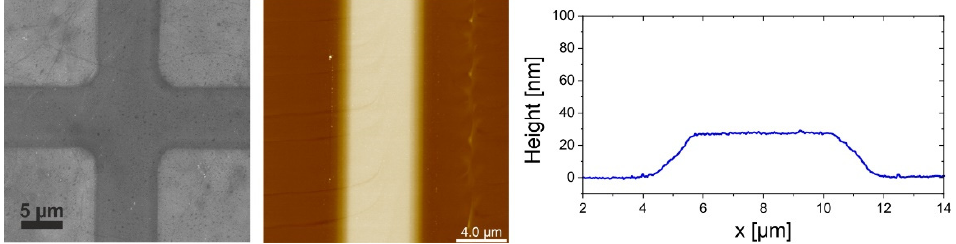
Figure 3. SEM ( left ) image of the metal grid covered with graphene and AFM ( center ) image along with an AFM profile ( right ) that shows the shallow slope of the lines.